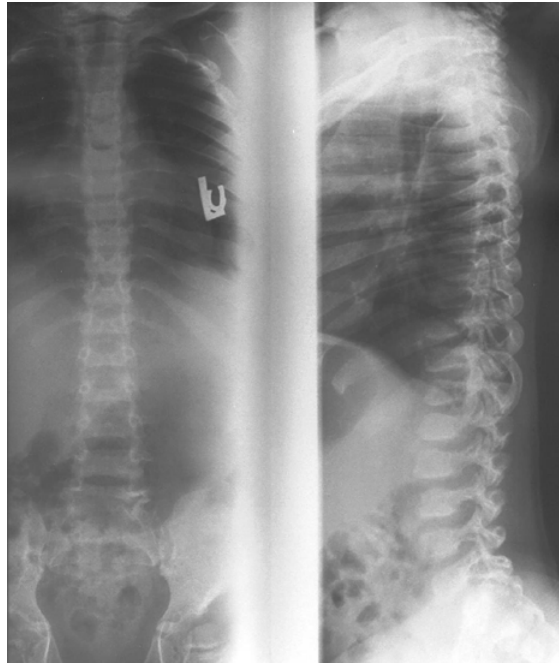
Figure 3. Rapidly progressing 7-year old female MPS VI patient: radiograph of spinal column showing abnormal development of vertebral bodies, paddle-shaped widened ribs, and severe